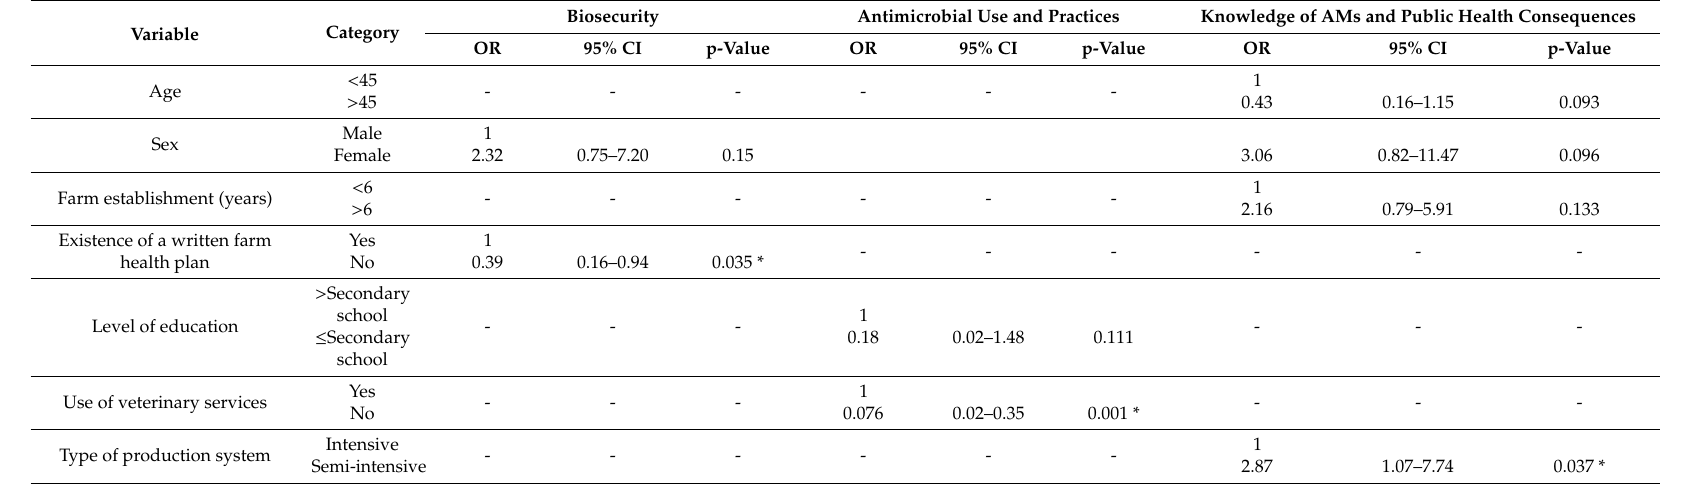
Table 4. Univariate binary logistic regression analysis of factors associated with levels of biosecurity, AMU, and knowledge among pig farmers in Ogun State.